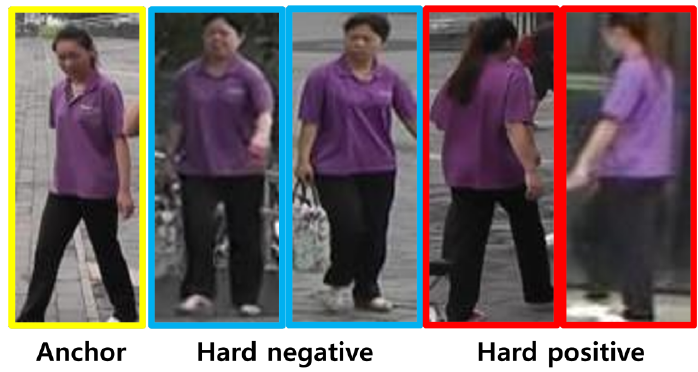
Figure 4. Examples of an anchor, hard negative, and hard positive